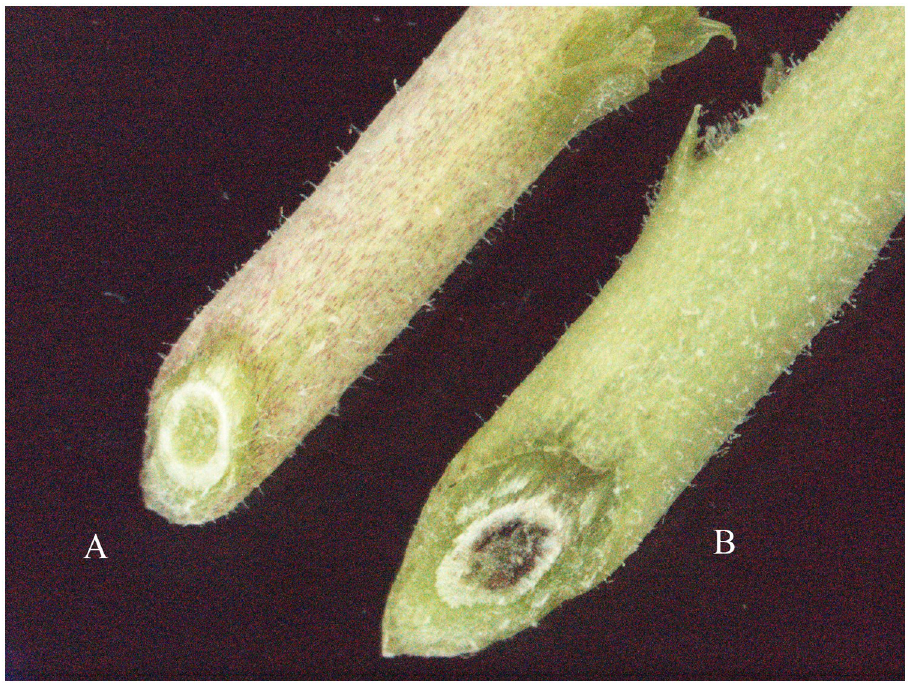
Fig 1. Cross-sectioned stems after six weeks of inoculation. (A) Resistant line to Fusarium race 5 (RIP8-94-5). (B) Susceptible line to Fusarium race 5 (RIP8-94-11).